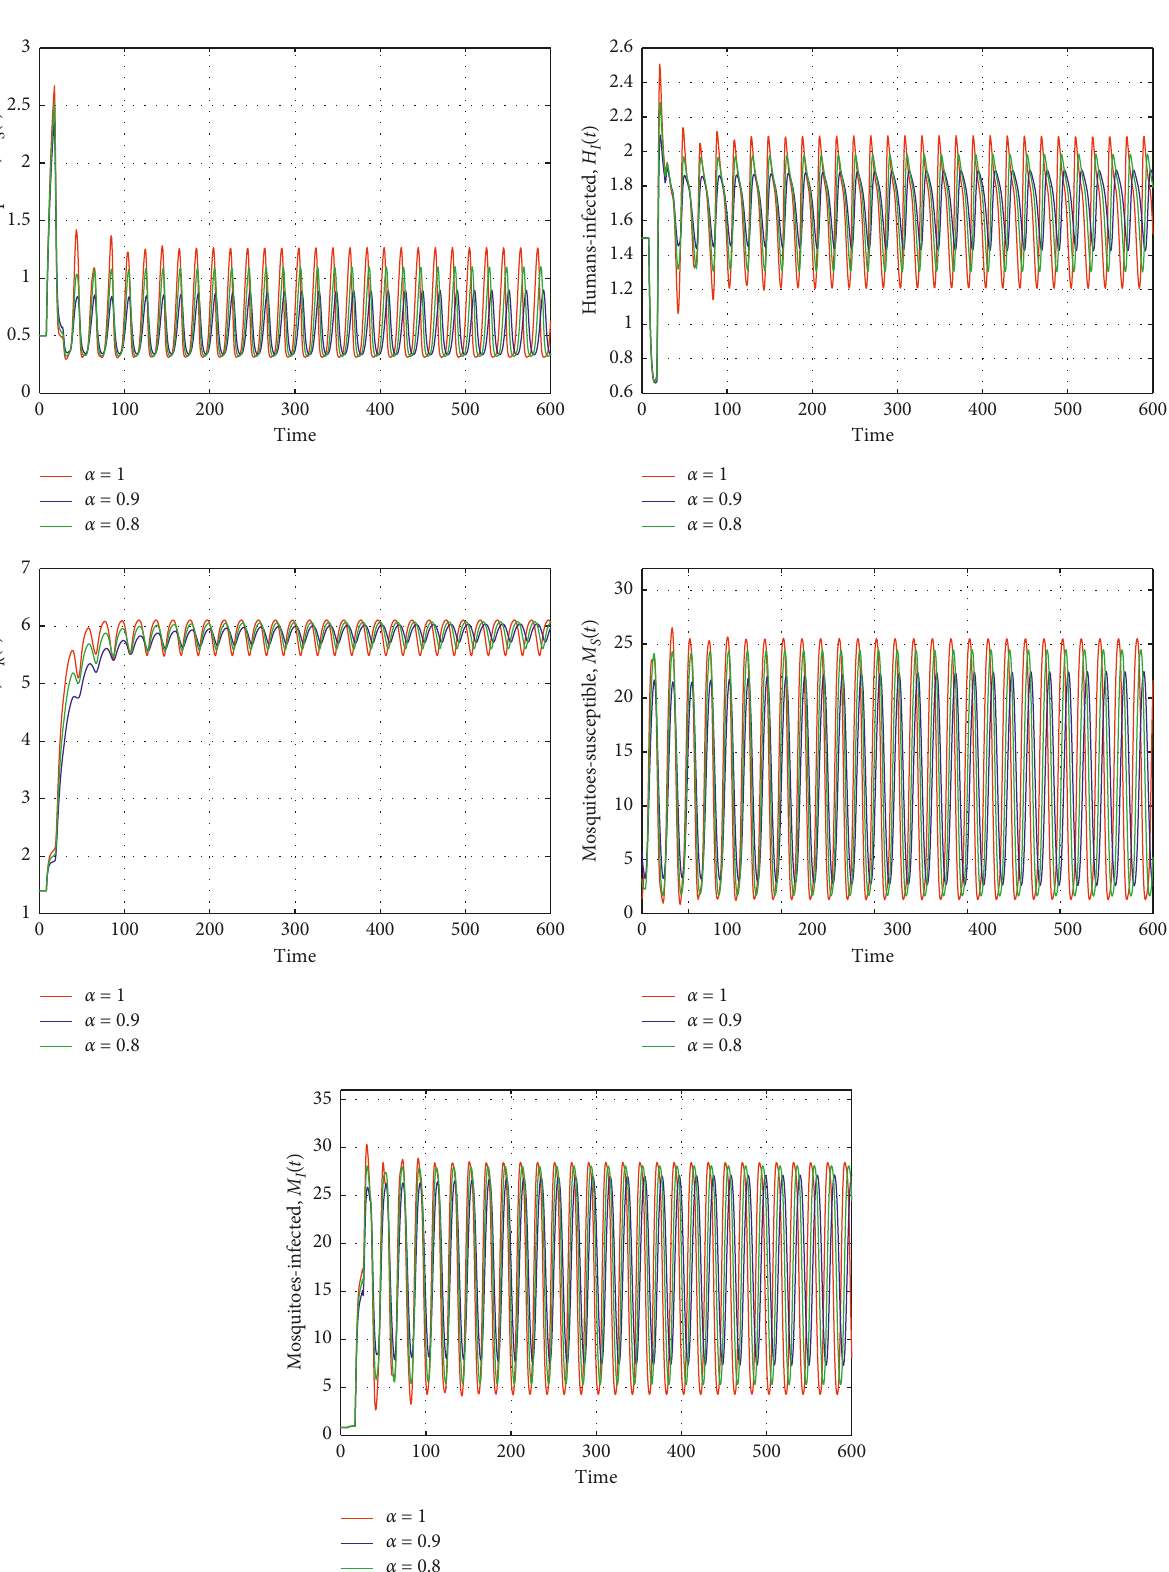
� 0 . 0 , τ � 0 . 0 , and τ � 8. The equilibrium point 1 2 3